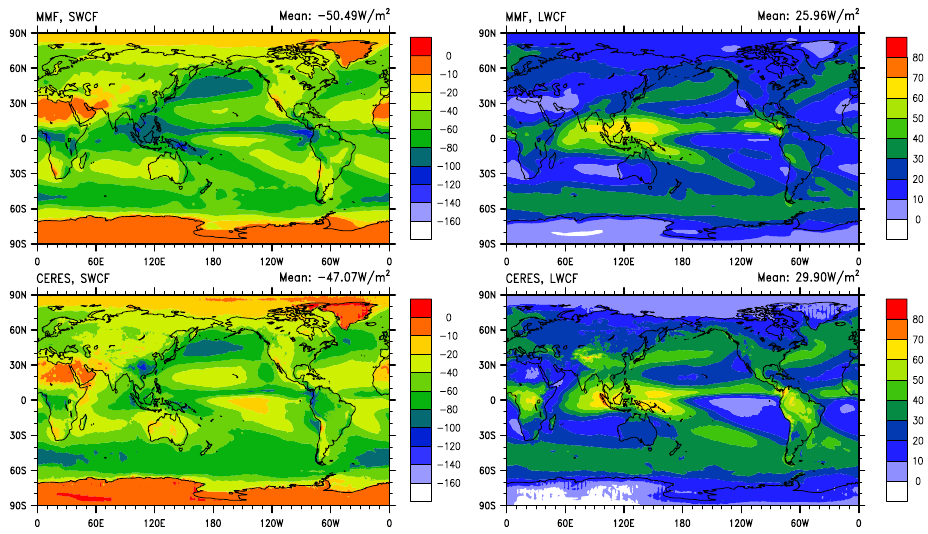
Fig. 4. PD annual average shortwave (left panels) and longwave (right panels) cloud forcing from the MMF model (upper panels) and from the CERES observations (lower panels).